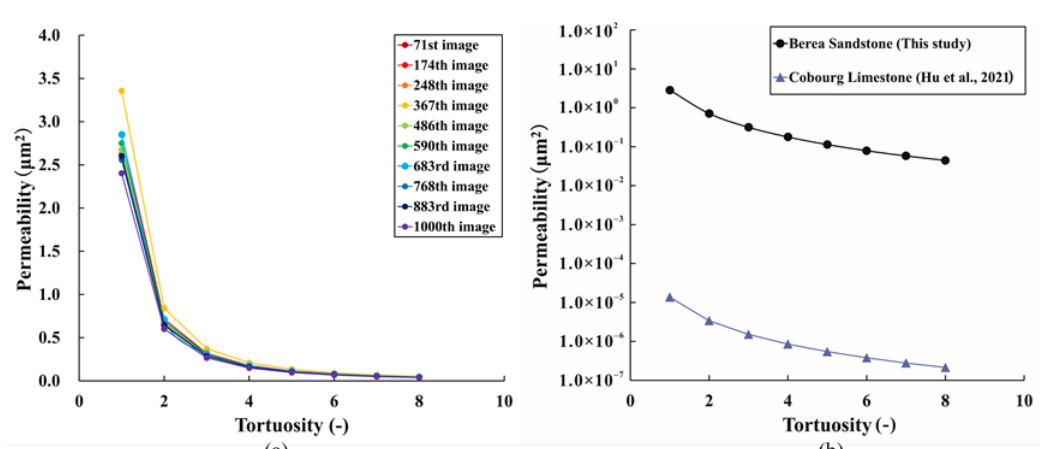
Figure 7. ( a ) Relationships between tortuosity values and permeability coefficients calculated on the pore geometry data from 10 selected images of Berea Sandstone; ( b ) relationships between tortuosity values and permeability coefficients calculated on the pore geometry data from the 683rd image of Berea Sandstone and BIB-SEM image of Cobourg Limestone [46].